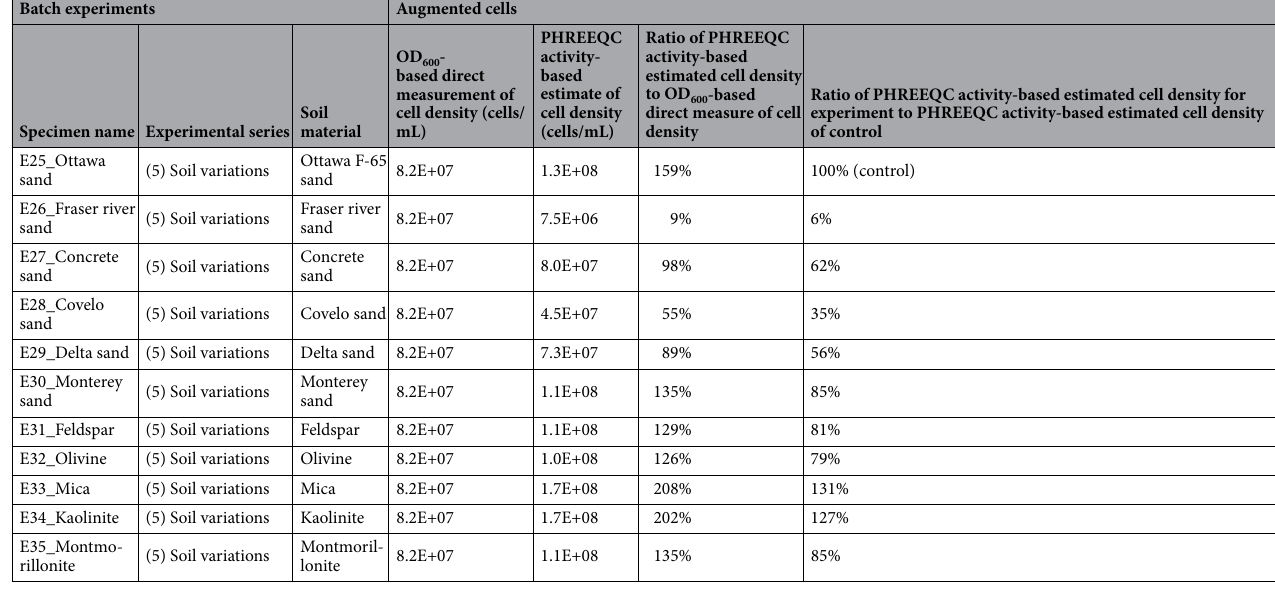
Table 1. Summary of all batch experiments, treatment solution compositions, and augmented cell measurements and